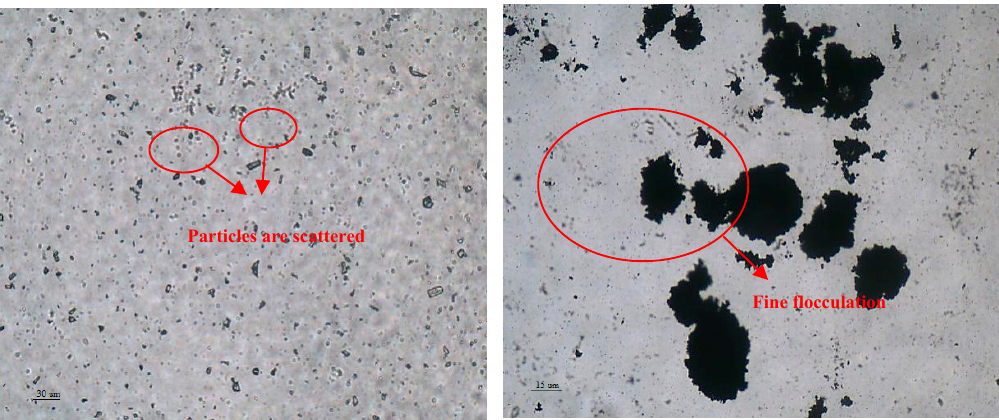
Figure 8. Distribution of malachite particles under the microscope before and after adding ZH-1.